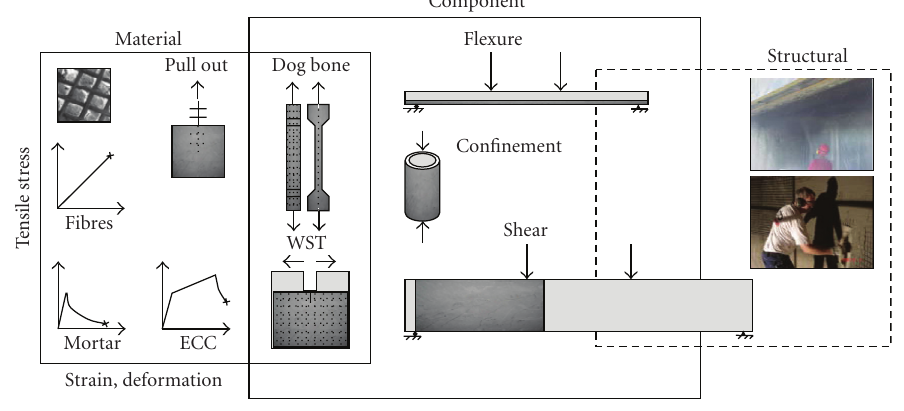
Figure 1: From material to structural